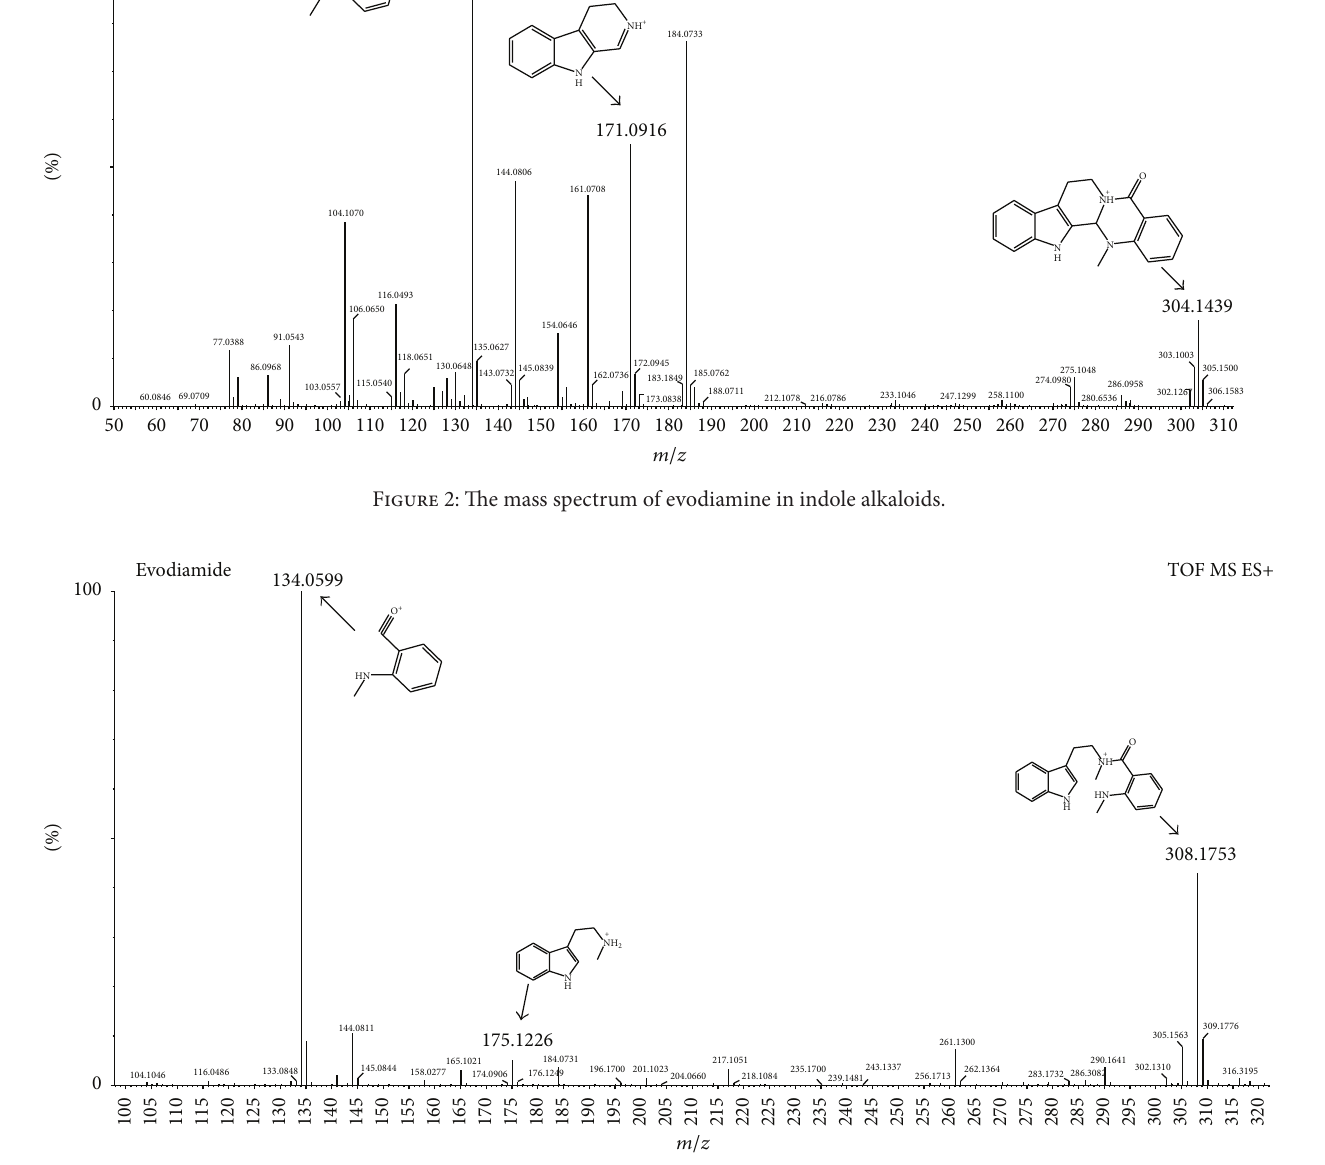
Figure 3: The mass spectrum of evodiamide in indole